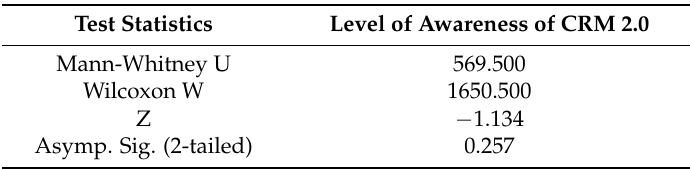
Table 3. Mann–Whitney U test for differences between contracting and consulting firms in their awareness with CRM 2.0.